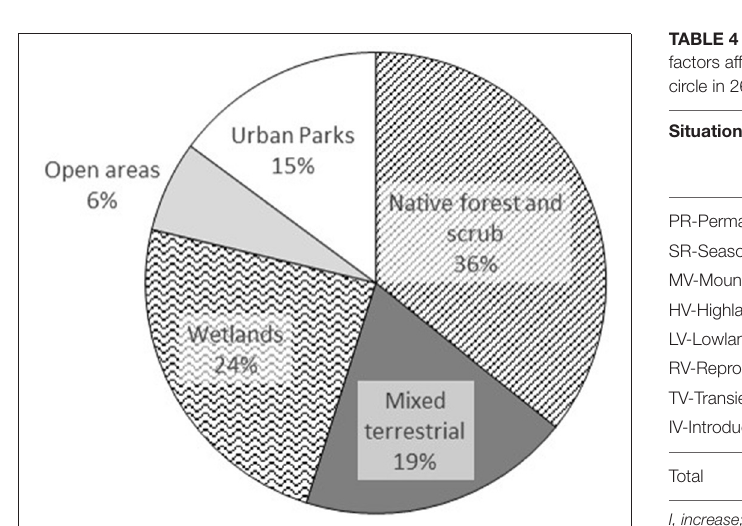
FIGURE 6 | Percentages of habitats preferred by the 235 bird species recorded in the Sabana de Bogotá Audubon’s Christmas Bird Count circle between 1989 and 2014.